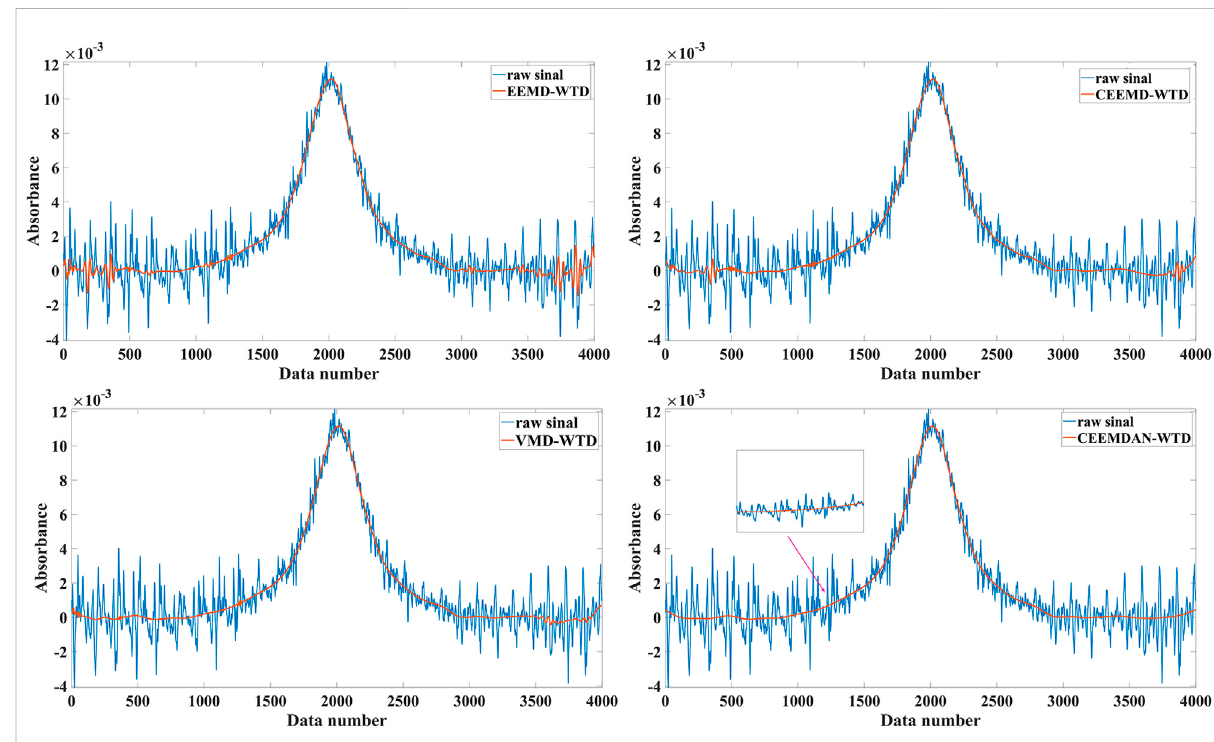
FIGURE 10 DAS signal of CO 2 detected in the experiment and the denoising result by using EEMD-WTD, CEEMD-WTD, VMD-WTD and CEEMDAN-WTD.